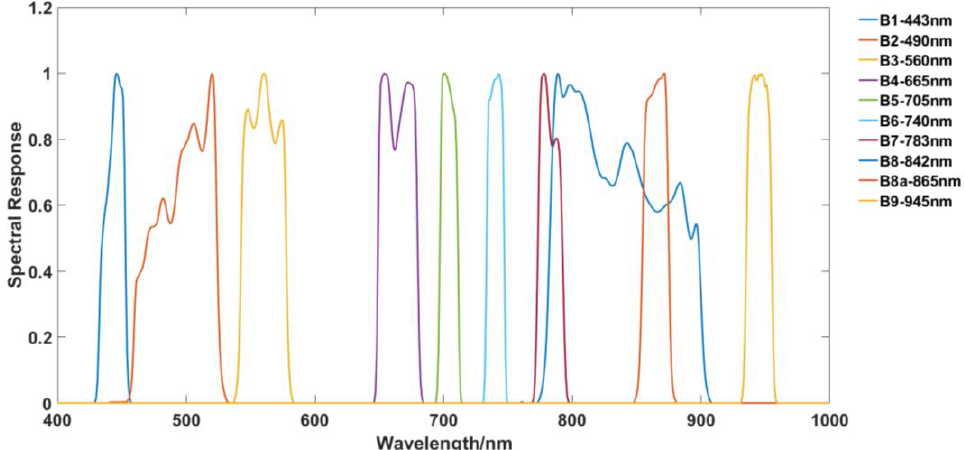
Figure 2. The Sentinel-2A spectral response functions of bands (B1–B9) in 400–1000 nm.